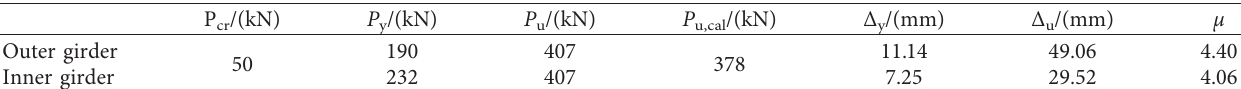
Figure 6: Measurement contents (unit: mm): (a) layout of test section; (b) the strain gauge distributions of test section. Table 4: The main quantitative features of the